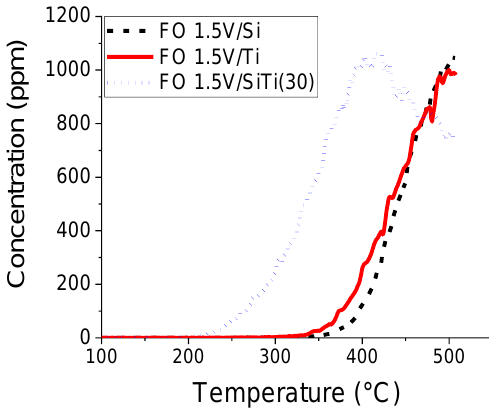
Figure 7. Formation of formaldehyde over pure silica or/and titania supports with 1.5% vanadium pentoxide during the oxidation of methanol and methyl mercaptan (feed 500 ppm + 500 ppm, heating rate 5 °C min −1 ).